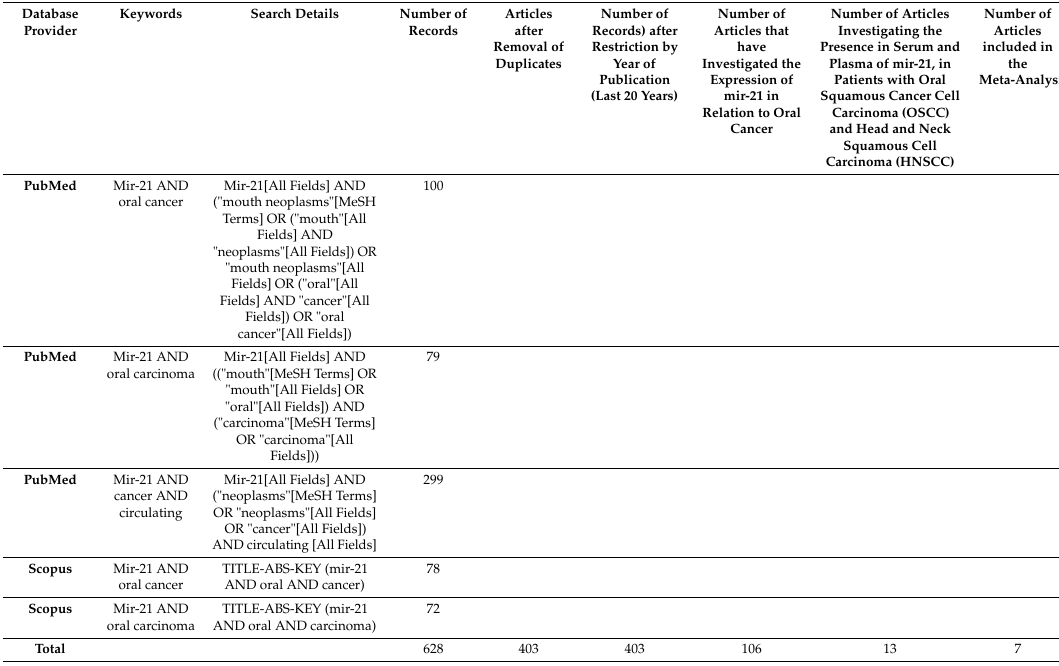
Table 1. Complete overview of the search methodology. Records identified by databases: 628.